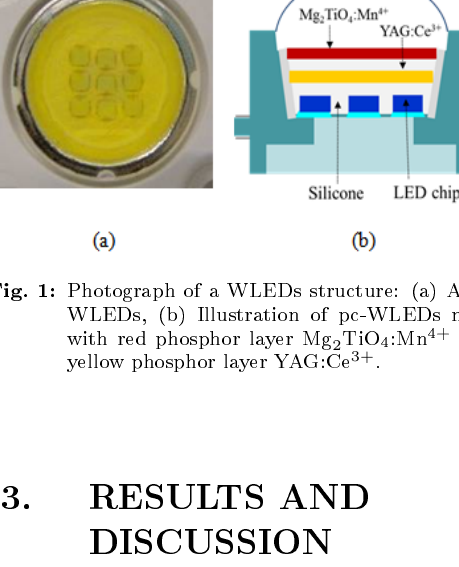
Fig. 2: The change of phosphor concentration for keep- ing the average CCT.